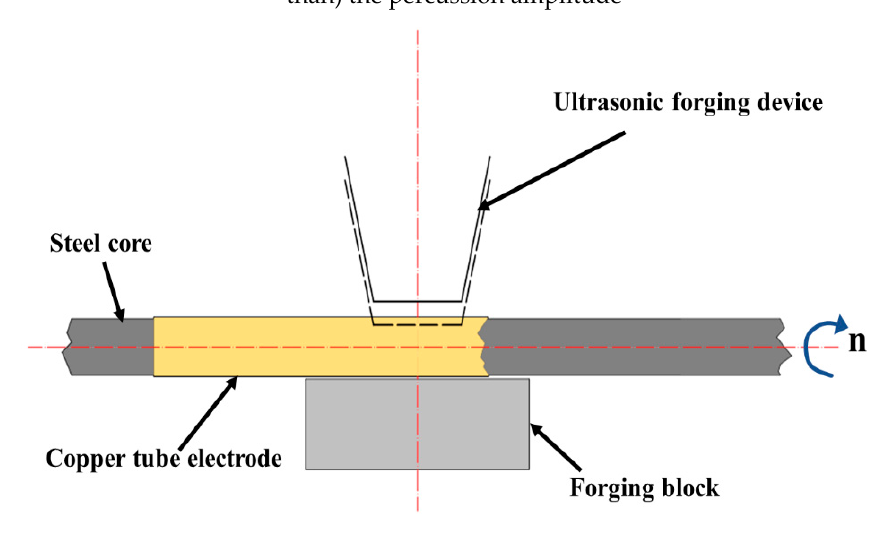
Figure 6. Machining conditions resulting from different machining clearances.